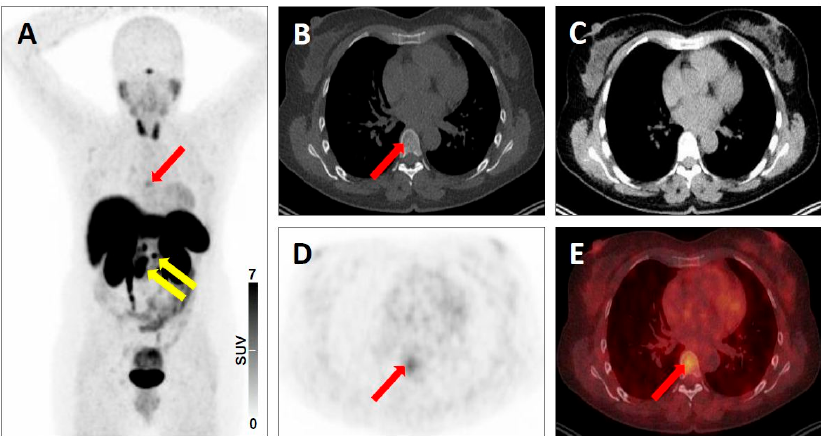
Figure 5. Equivocal uptake in bone lesion on SSTR-targeted positron emission tomography (PET)/computed tomography (CT). 68 Ga-DOTATATE PET/CT for restaging in a 52-year-old woman with a history of ileal neuroendocrine carcinoma. Whole-body maximum intensity projection image showing multiple metastases to lymph nodes with clearly pathologic radiotracer uptake (yellow arrows), consistent with SSTR-RADS 5 lesions and a faint osteolytic bone lesion (red arrow) ( A ). Axial low-dose bone-window CT image ( B ), soft-tissue window CT image ( C ), PET image ( D ), and fused PET/CT image ( E ) further show this faint osteolytic bone lesion on anatomic imaging with equivocal uptake (red arrows), consistent with a SSTR-RADS-3B lesion.